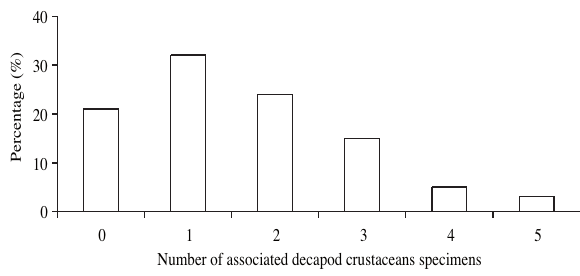
F IG . 1. – Percentage of sea anemones Anemonia sulcata displaying associated decapod crustaceans (n =